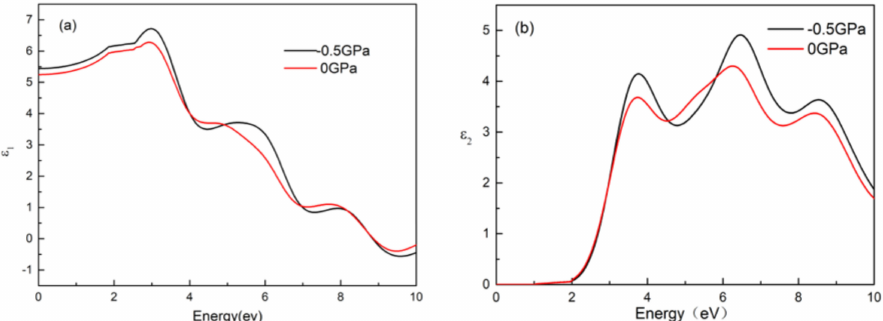
Figure 7. The dielectric function of CsGeI 3 of ( a ) real and. ( b ) imaginary under the pressure of 0 GPa and − 0.5